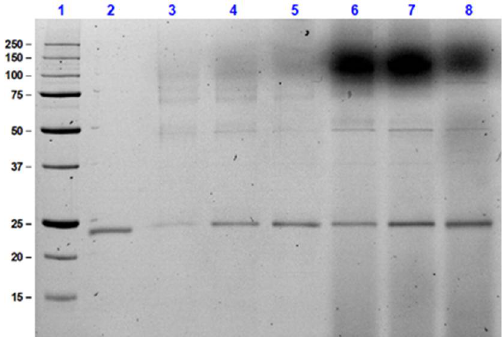
Figure 6. SDS PAGE analysis of recombinant thaumatin expression using 17.5% SDS-PAGE